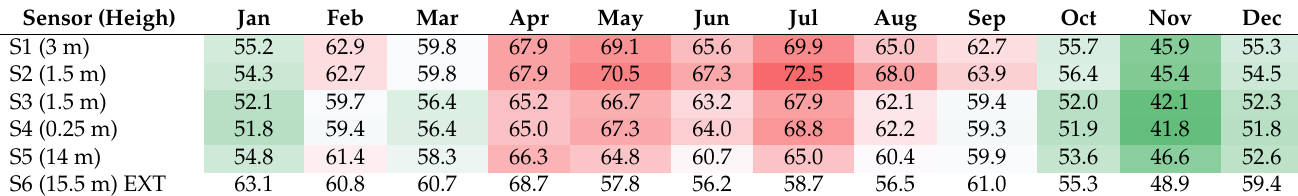
Table 7. Average relative humidity RH (%) registered by the sensors.